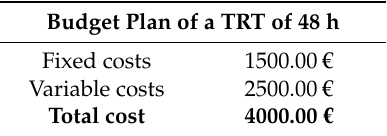
Figure 14. Initial investment associated with each interval as a function of the heat exchanger configuration.